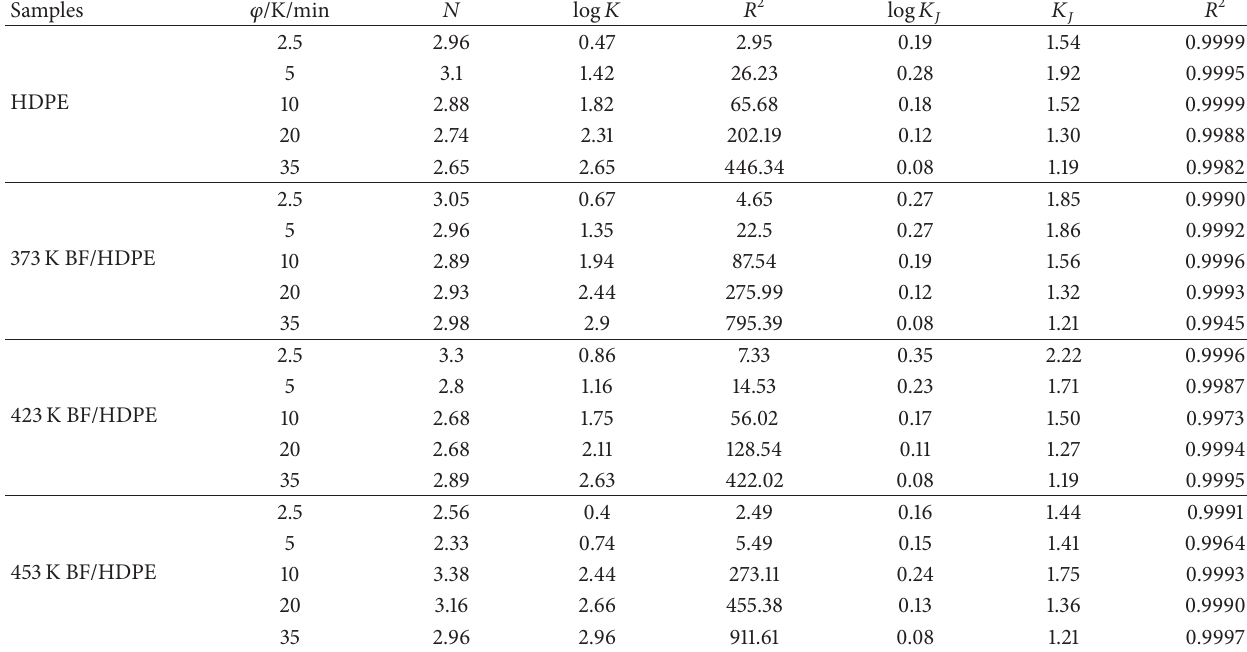
Table 2: Nonisothermal kinetic parameters at different relative crystallization of HDPE and its composites based on the Jeziorny model. Samples 𝜑 /K/min